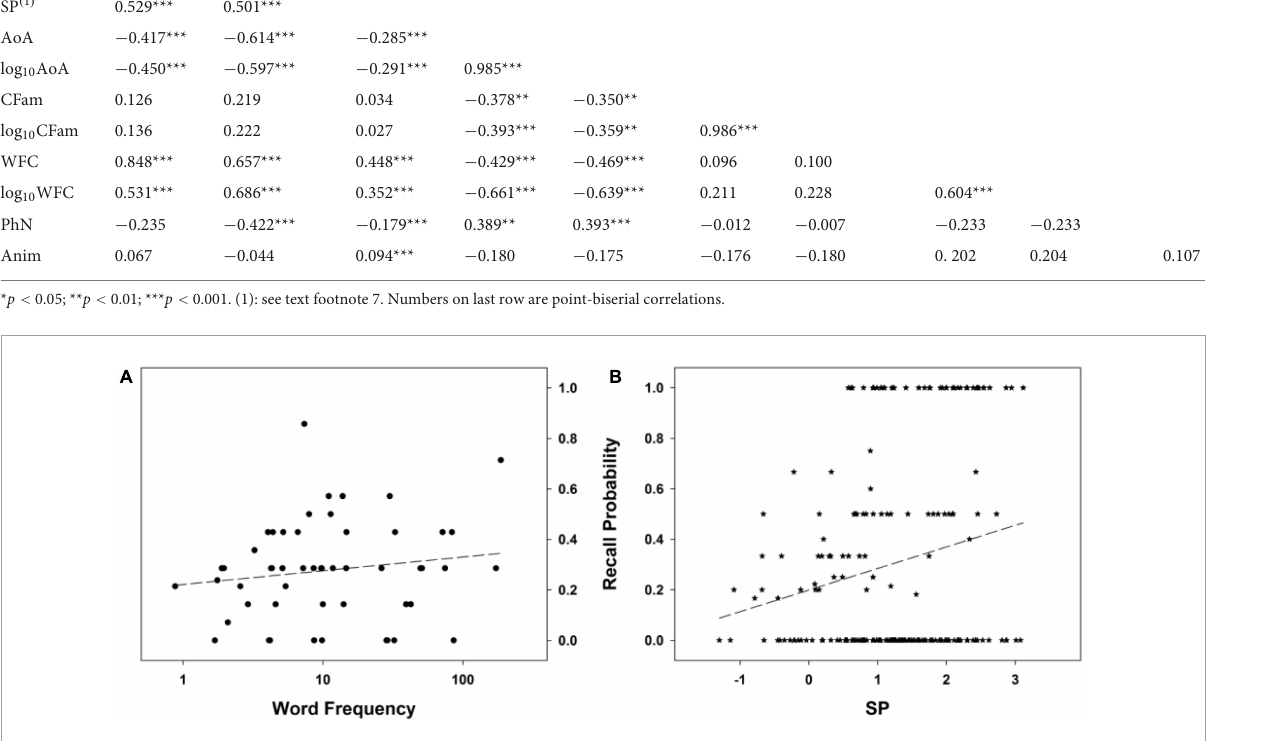
is not just a replication of Experiment 1 with more